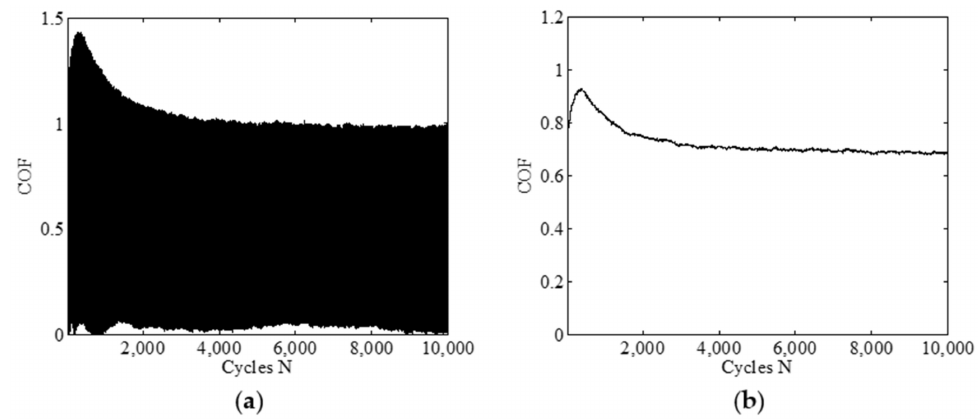
Figure 3. The friction coefficient of FPM under F n = 5 N, d = ± 0.45 mm, f = 10 Hz, and H = 70 Ha: